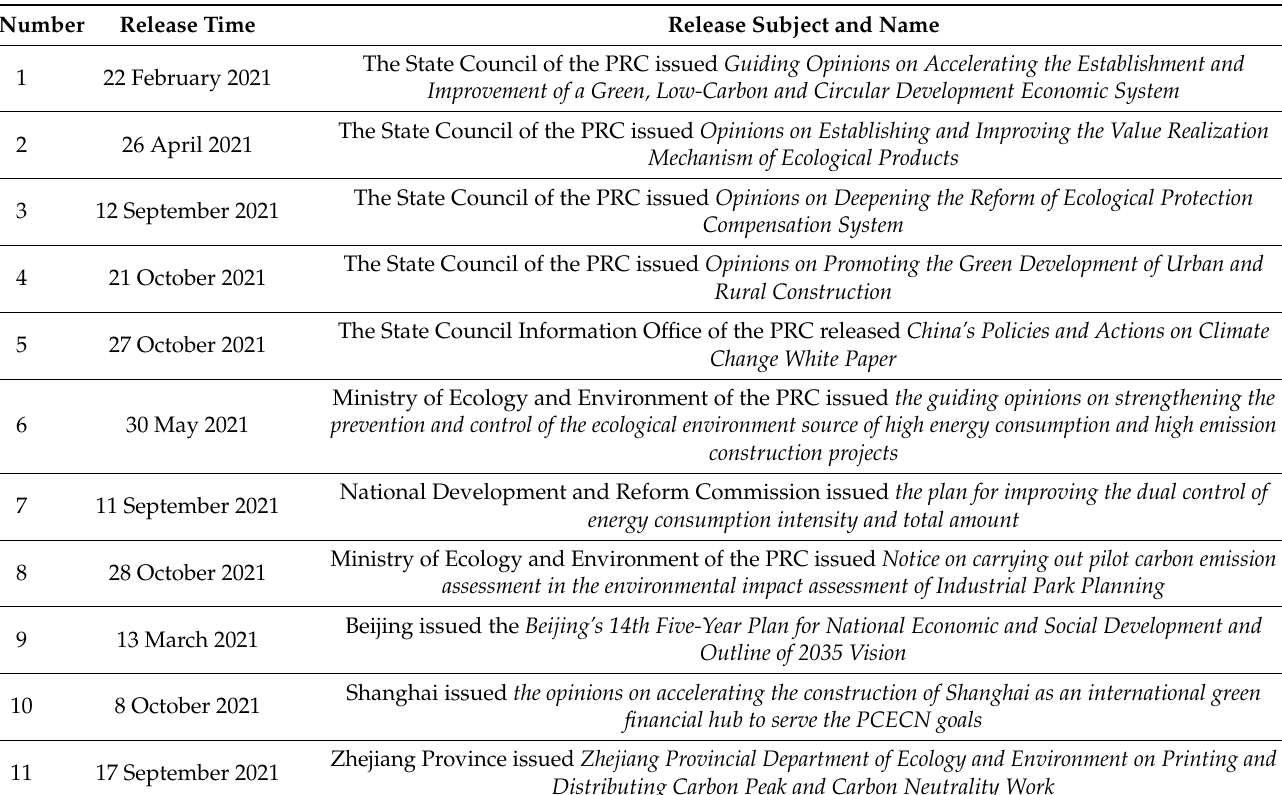
objects, as shown in Table 1. Table 1. The PCECN policies for Table 1. The PCECN policies for analysis.